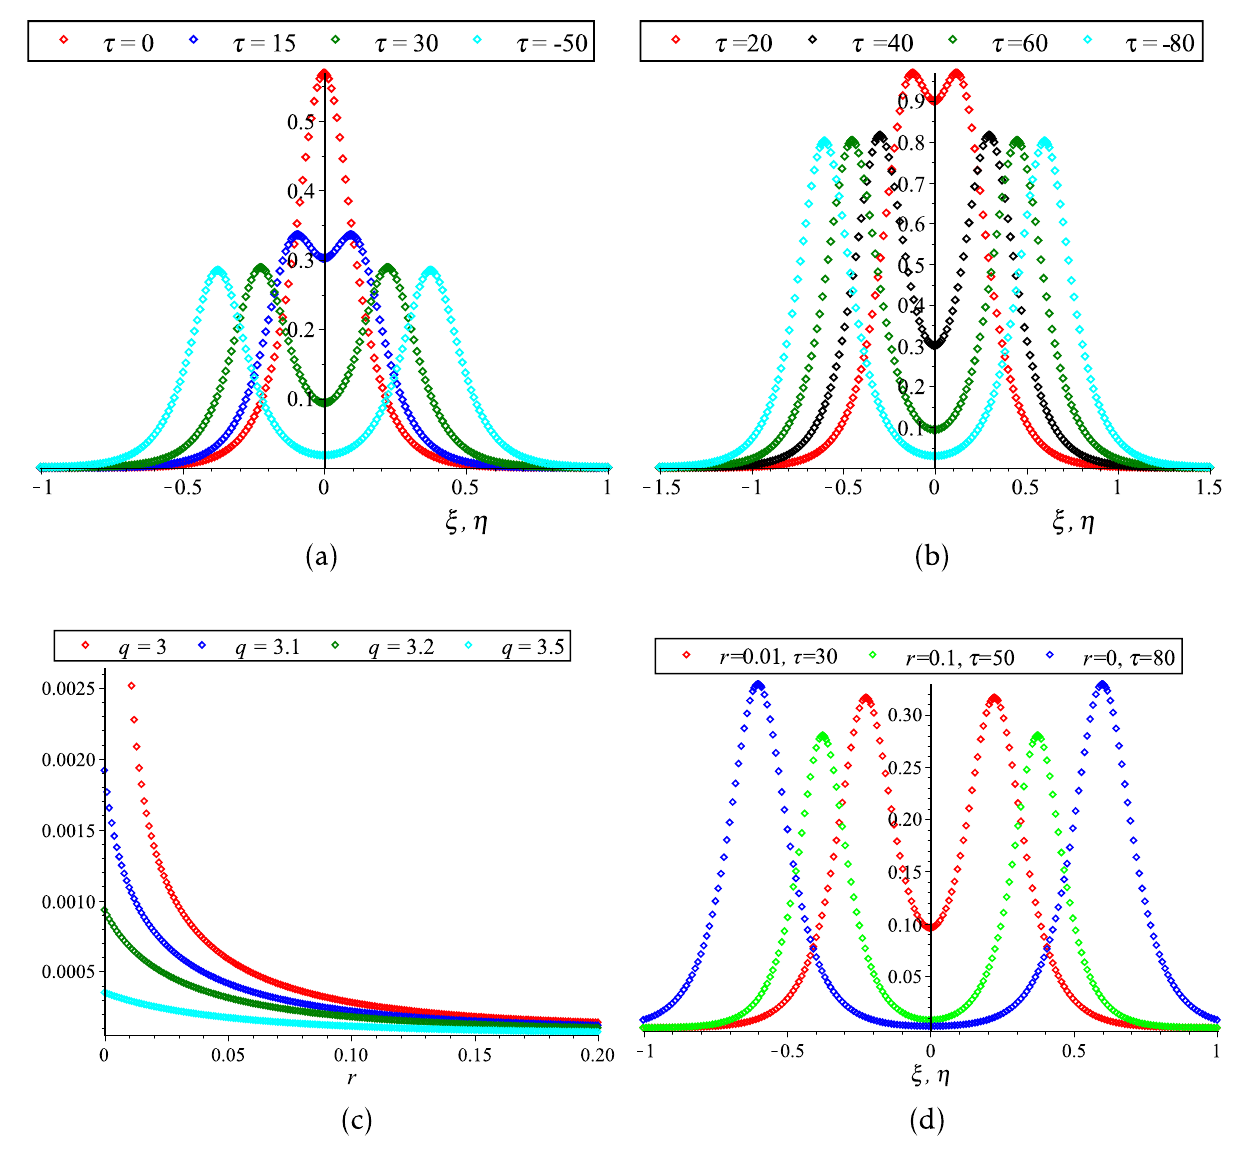
1 ) = φ ( 1 ) + φ ( 1 ) r (cid:30) with different values of τ around ( a ) Figure 6. Collisional PA mKdVSs (cid:31) φ ( l K v = 0.006,538,446,158 ( N hc = 0.08) and ( b ) K v = 0.006,538,446,158 ( N hc = 0.1) with N ec = 0.5, δ = 0.5, σ = 1, q = 3, r = 0 and U 0 = 0.0075; ( c ) their phase shift Δ Q 0 due to the collision between two PA mKdVSs with N hc = 0.08, N ec = 0.5, δ = 0.5, σ = 1, σ = 1, q = 3, r = 0 and U 0 = 0.0075; and ( d ) effect of r ( q = 3.5) on collisional PA mKdVSs with N hc = 0.08, N ec = 0.5, δ = 0.5, σ = 1, and U 0 =